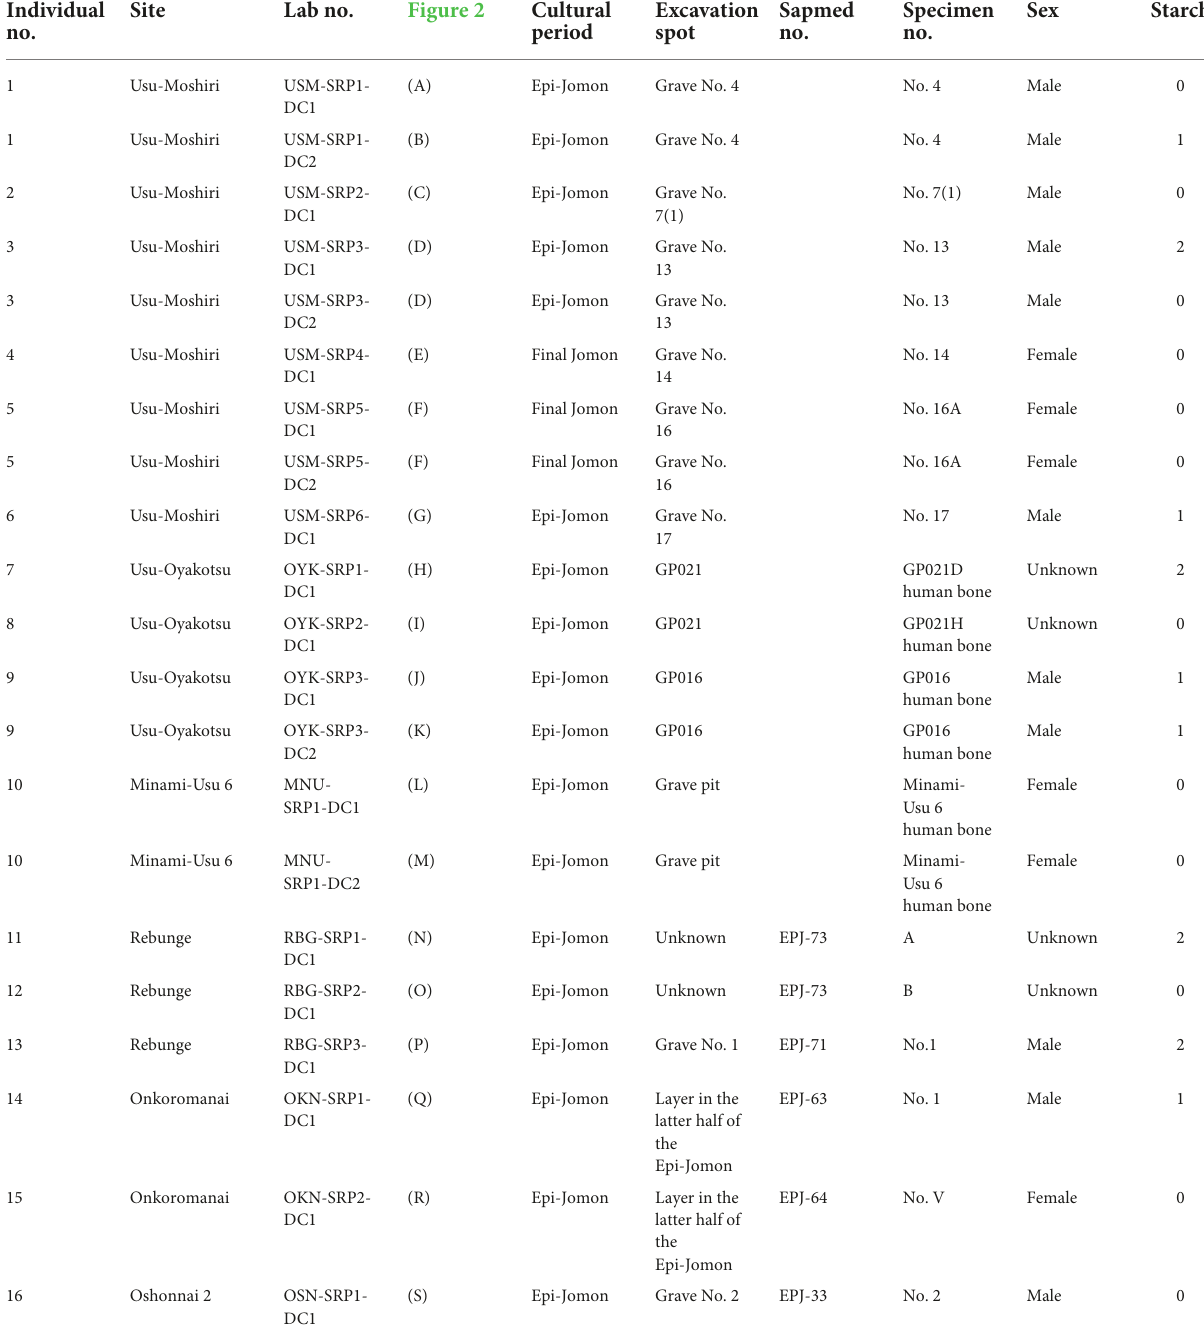
TABLE 1 Dental calculus sample information (Sapmed no.: Sapporo Medical University material no.). Individual Site Lab no. Figure 2 Cultural no.